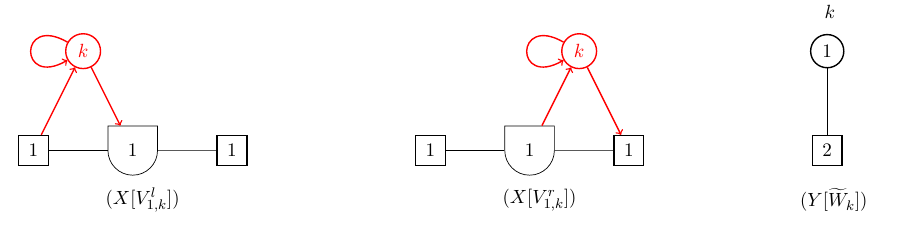
Figure 22 . The two 3d-1d systems that realize the 3d vortex operator V 1 ,k in a U(1) gauge theory with two hypermultiplets. The mirror dual is a gauge Wilson defect of charge k